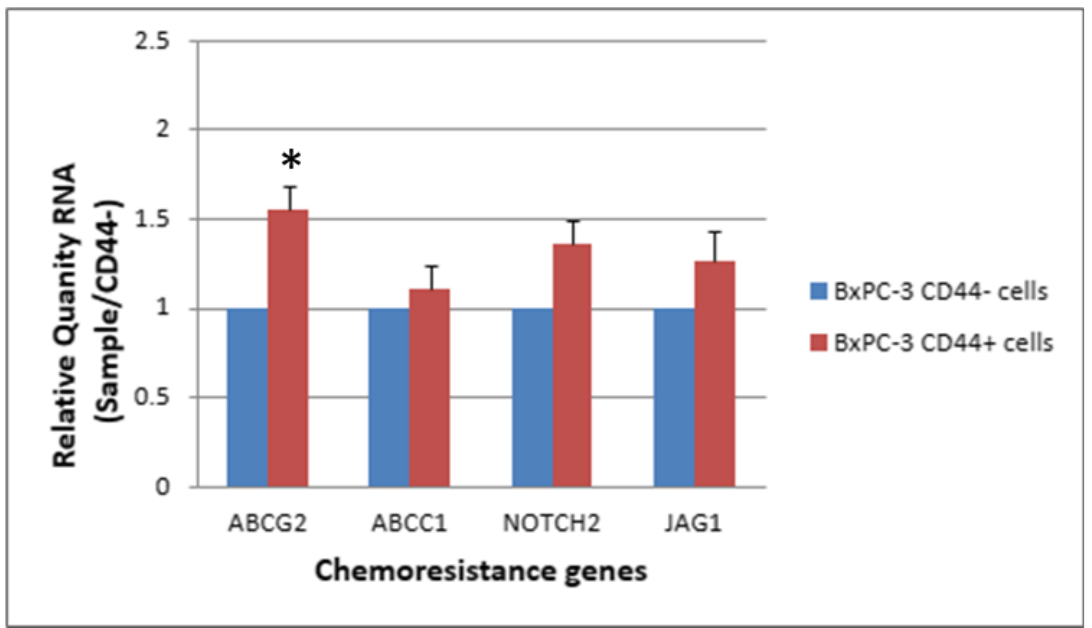
Figure 7. The response of 4 chemoresistance genes for CD44+ cancer stem cells and CD44−BxPC-3 PDAC cells treated with gemcitabine (25 nM, 48 h) is shown. The ABCG2 gene had significantly higher expression in CD44+ than CD44−, * < 0.05. (Mean ± SD).